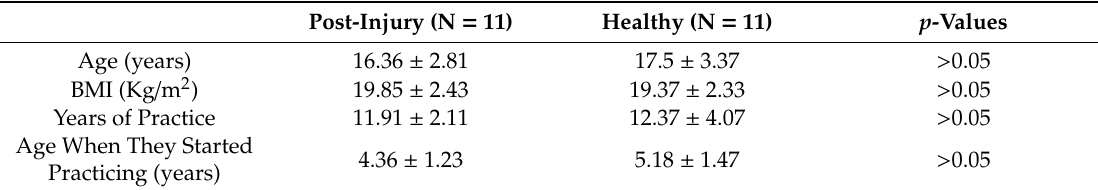
Table 1. Demographical data of participants.